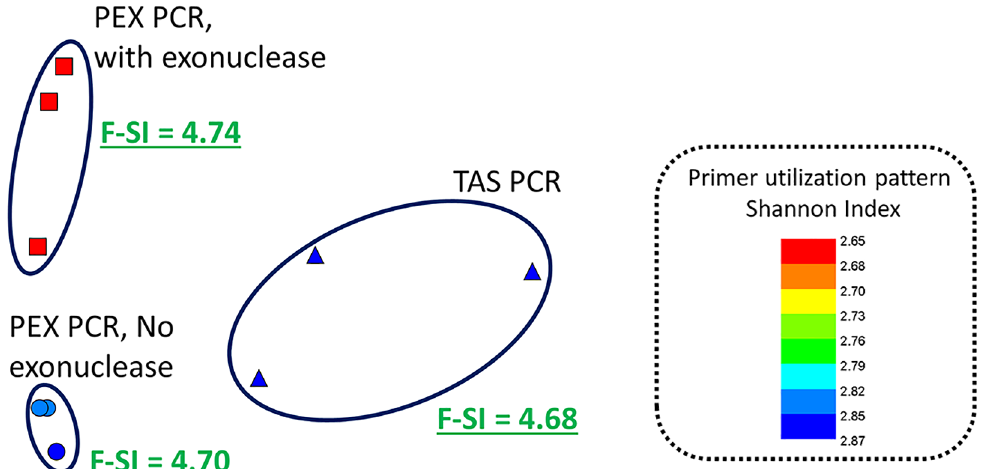
Fig 6. Effect of PEX PCR and exonuclease treatment on observed microbial community structure and primer utilization patterns. Non-metric multidimensional scaling (NMDS) plot of lake sediment microbiome, performed at the taxonomic level of family and based on Bray-Curtis similarity (2D stress = 0.02). Samples were rarefied to 35,500 sequences per sample and no transformation was applied. All reactions were performed with an annealing temperature of 45°C, using PEX PCR with exonuclease (squares), PEX PCR without exonuclease (circles), and TAS PCR (triangles). Symbols are color- coded by the diversity (Shannon Index) of reverse primers ( i . e . 806R) detected in the sequences. Maximum possible Shannon index for 18 primers in the primer pool is 2.89. Small, but significant differences in the observed family-level Shannon index (F-SI) were observed between PEX PCRs (with and without exonuclease treatment) and TAS PCRs using a two-tailed ttest (p < 0.05).